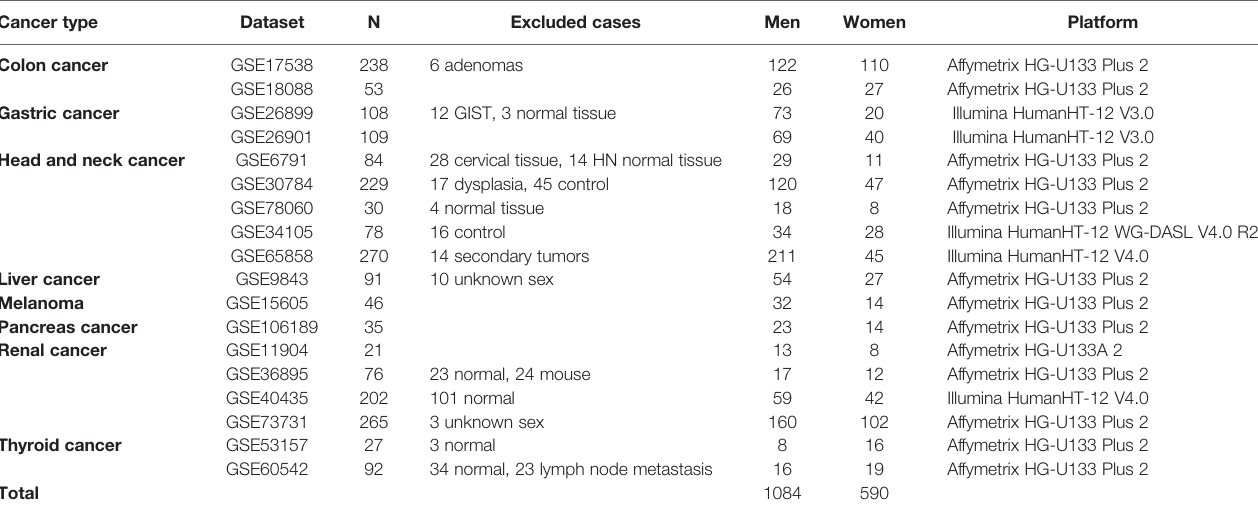
TABLE 1 | Datasets included in the GSEA study to identify different immune process activated in men vs . women. Cancer